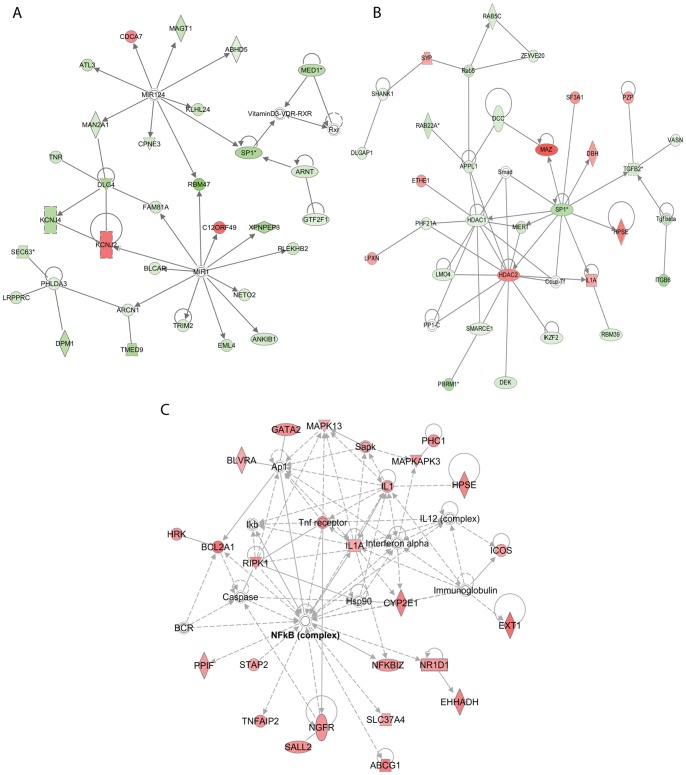
IPA network analysis at 24 h.The three highest scoring networks from the LRG list are shown. See Figure 5 legend for further details.